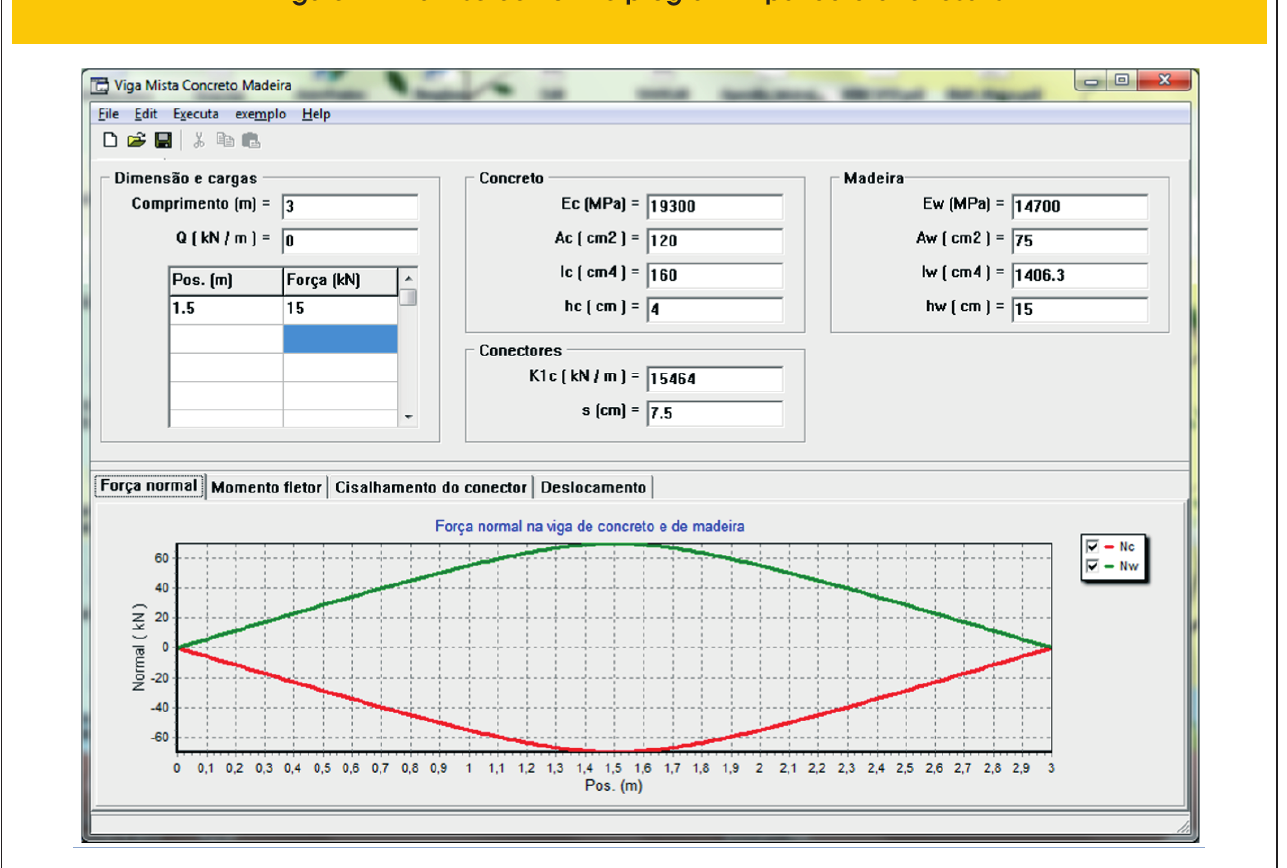
Figure 7 – Main screen of the program: input data and results